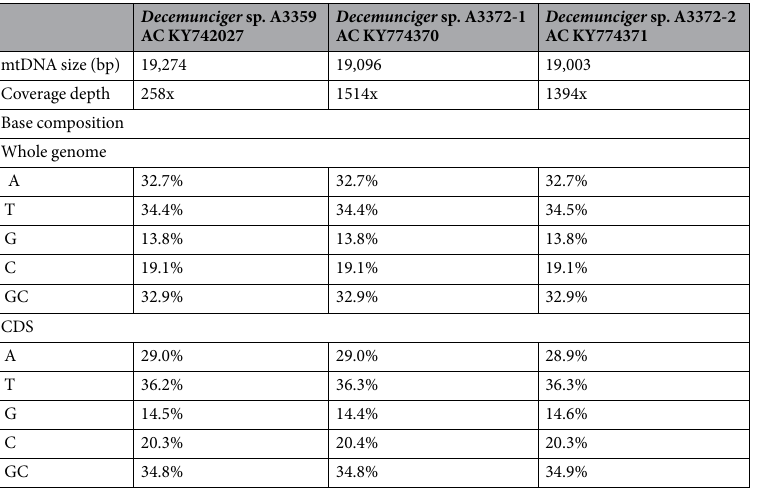
Table 1. Genome size, coverage, coverage depth and base composition of assembled Decemunciger sp. Mitochondrial genomes. AC - GenBank accession